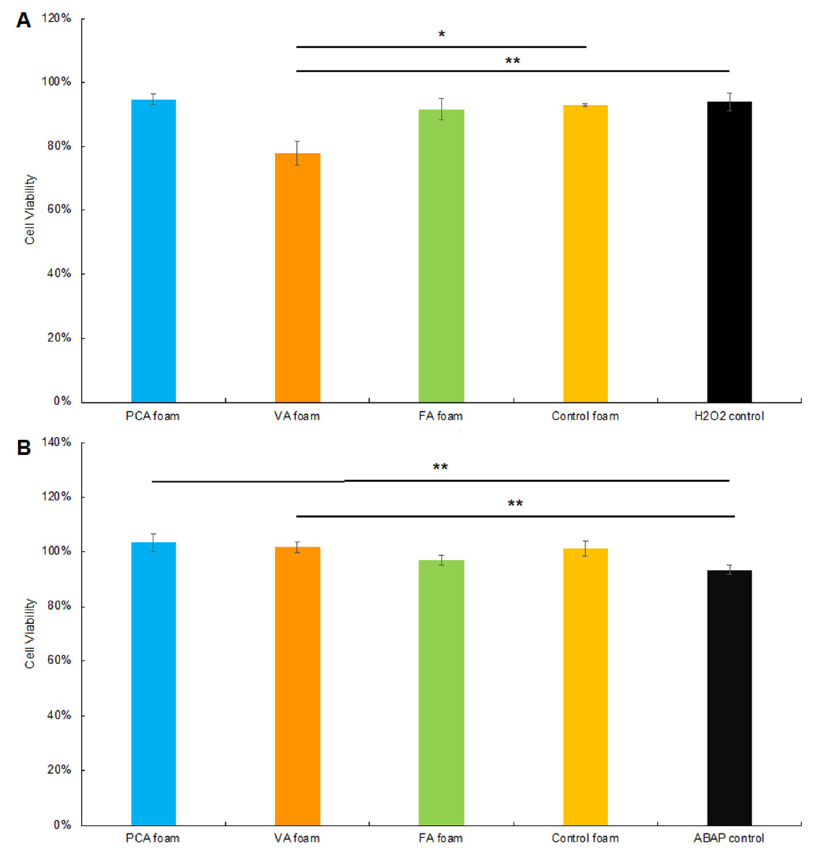
Figure 8. Caco-2 cell viability during the DCFDA/H2DCFDA assay process with SMP foams in ( A ) H 2 O 2 and ( B ) ABAP. n = 3, mean ± standard deviation displayed, * p < 0.05 between PA foams and control foam, ** p < 0.05 between PA foams and ROS control.